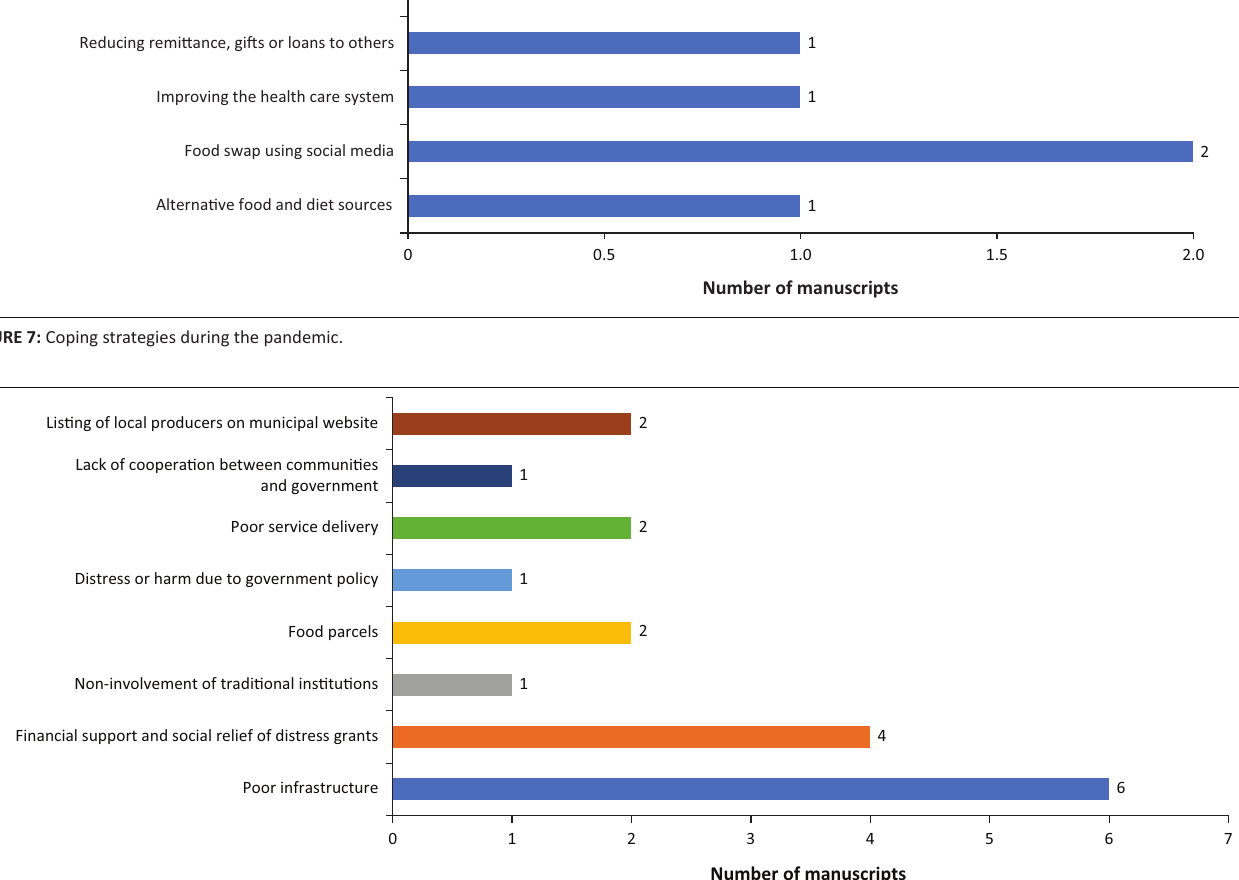
Reduced expenditure on educa(cid:17)on, transporta(cid:17)on; informal risk-sharing between households